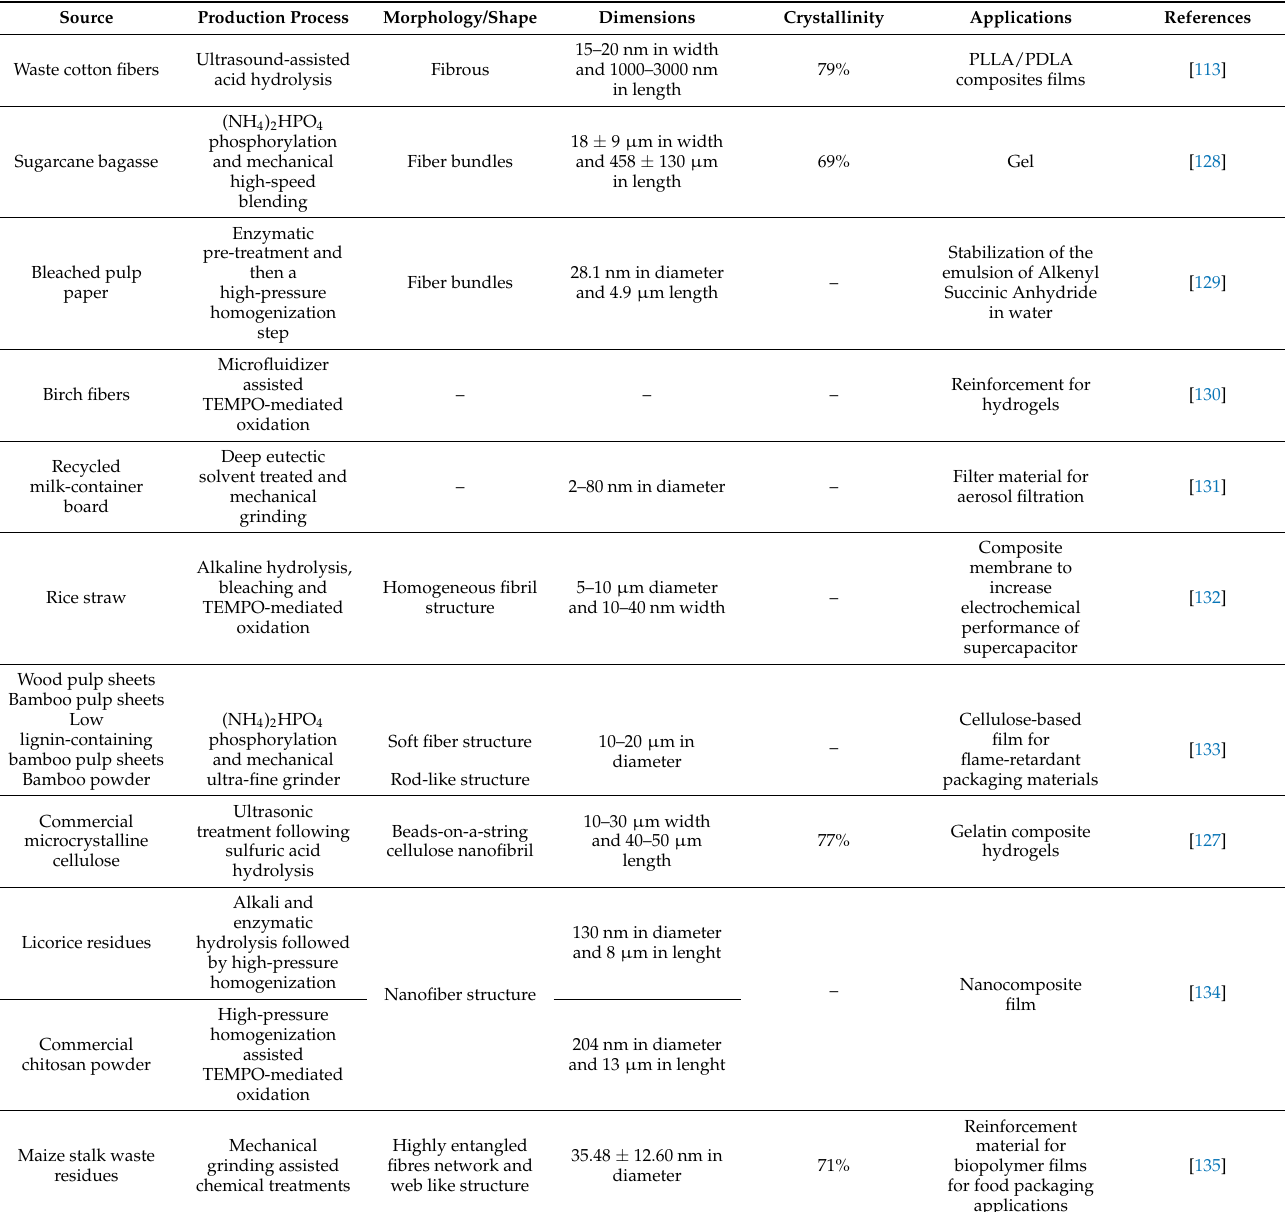
Table 4. Recent advances in the production process, physicochemical characteristics and application of CNF extracted from different sources (literature data for years 2020 and